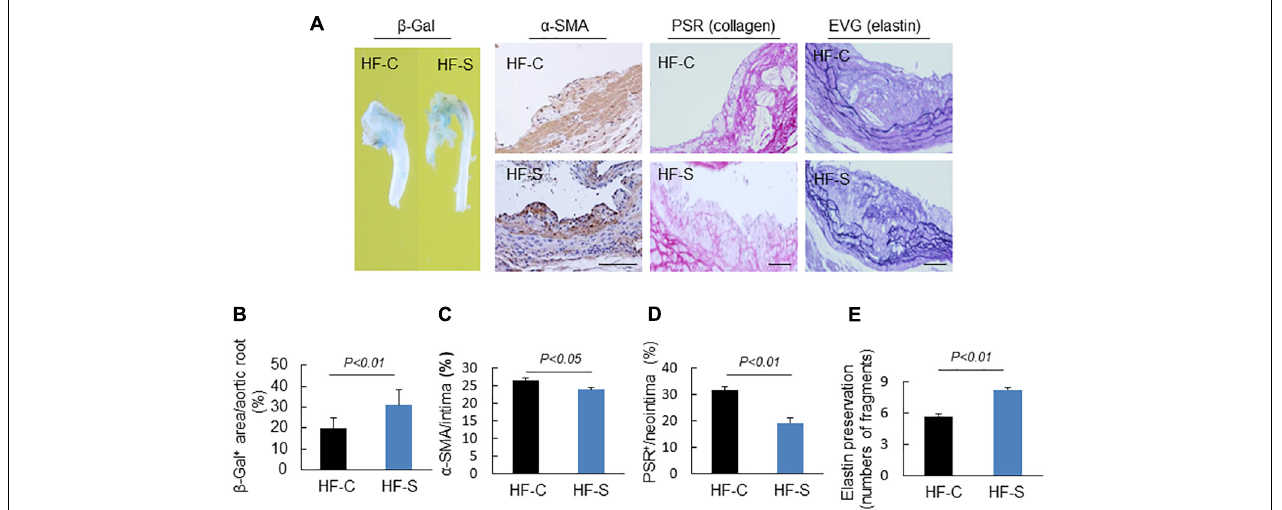
FIGURE 3 | Morphological characterization of the plaques in aortic roots of two experimental groups. (A) Representative images applied to evaluate vascular senescence, α -SMCs, collagen, and elastin disruption. (B–E) The areas for β -Gal + , α -SMCs, PSR + staining, and the elastic disruption degree in atherosclerotic lesions were calculated for each section. Results are presented as the ratio of β -Gal + area to the total aortic root, the ratio of the positively stained area ( α -SMCs, PSR + ) to the neointimal area in the atherosclerotic lesions, and the elastic broken numbers in the atherosclerotic lesions. Values are presented as means ± SEM ( n = 6–7). p < 0.01 vs. HF-C by Student’s t -test. Scale bars: 50 µ m.